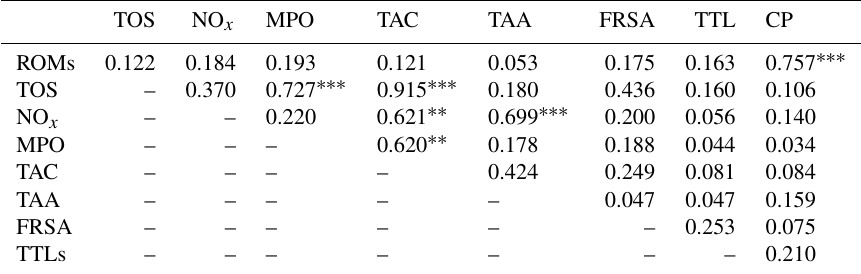
Table 2. Correlation matrix among the assessed parameters in goat kid serum. TOS NO x MPO – NO x – –